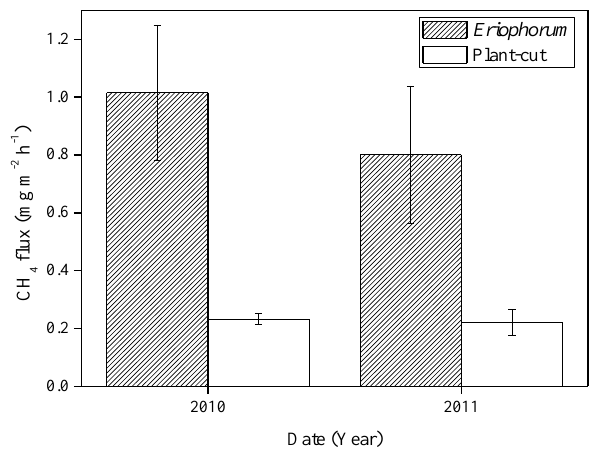
Fig. 5. Seasonal mean CH 4 flux from the EP and BP sites for both